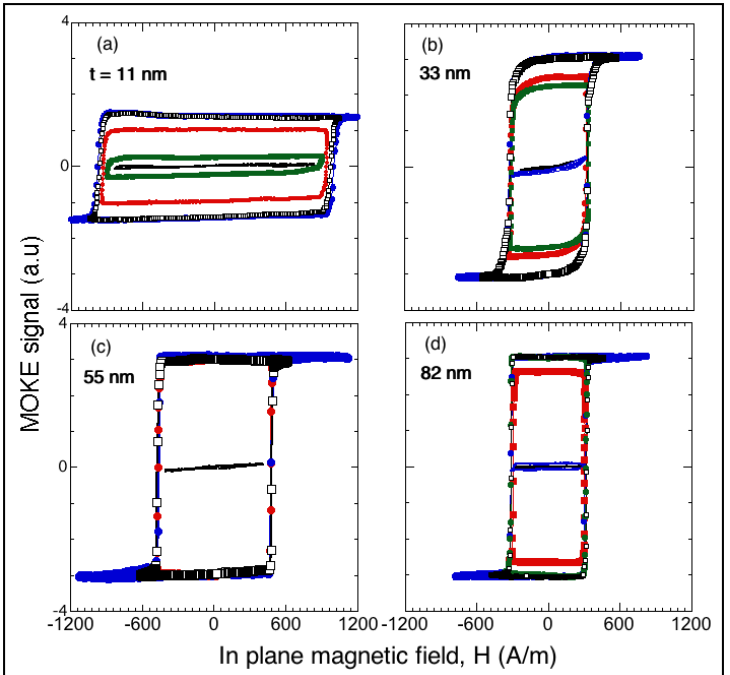
Figure 3. ( a – d ) MOKE hysteresis loops along the T direction corresponding to as-deposited Fe films with different thicknesses t showing different nucleation magnetic field values H N depending on t . Loops were obtained by applying magnetic fields of increasing strength so that irreversible nucleation and immediate displacement of magnetic walls could be precisely observed. Lines are visual